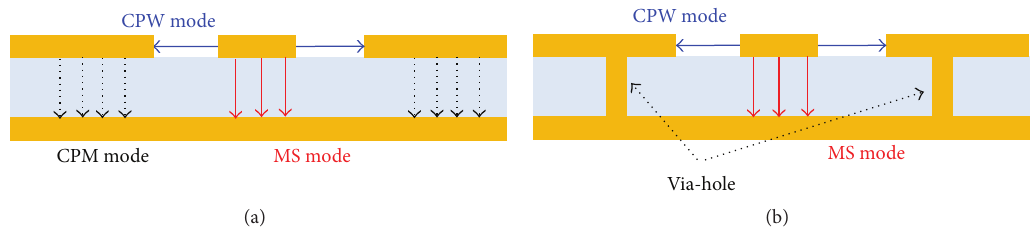
Figure 2: Different propagation modes in a grounded coplanar line structure; (a) without via-hole and (b) with via-holes.